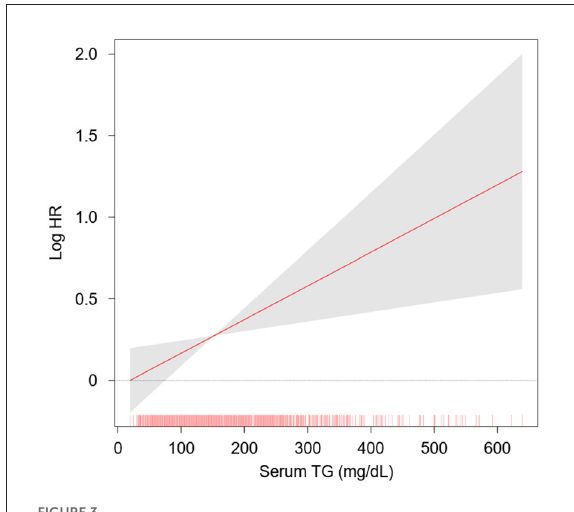
FIGURE3 Restricted cubic spline of serum TG level on composite renal event. Adjusted HR of serum TG level as a continuous variable for composite renal events is depicted. The model was adjusted for age, sex, BMI, WC, medication (diuretics, statins, ACEi/ARBs, number of antihypertensive drugs), SBP and DBP, primary renal disease, smoking history, Charlson comorbidity index, CACS, hemoglobin, 25(OH) vitamin D, albumin, fasting glucose, LDL-C, HDL-C, total cholesterol, hs-CRP, CKD stage and spot urine ACR. HR, hazard ratio; TG,